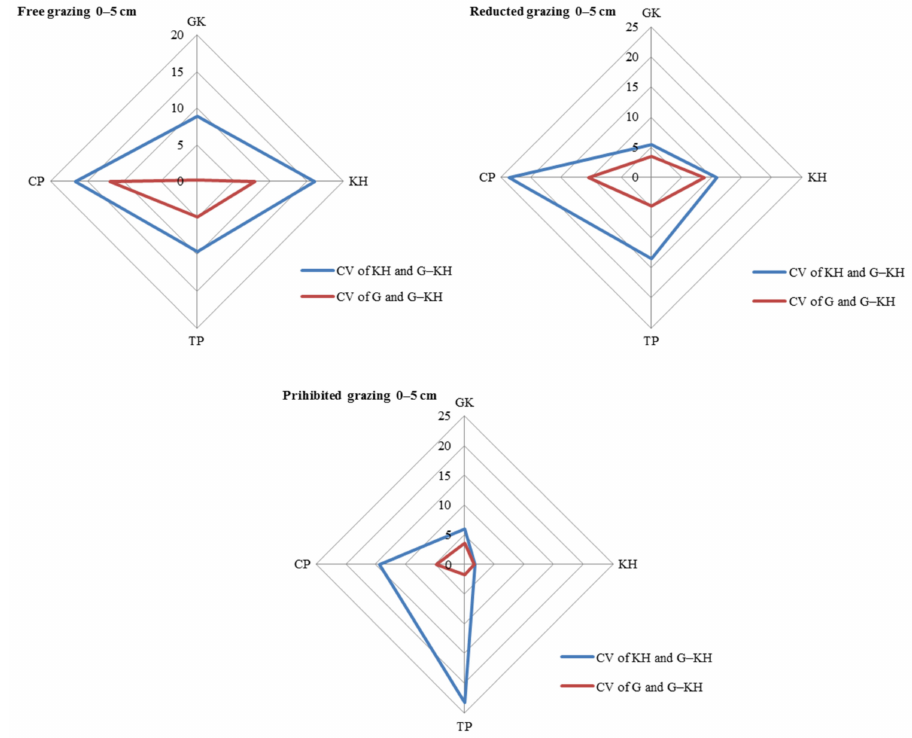
Figure 3. Coefficient of variation (CV) in soil organic matter content in the 0–5 cm layer between micro-patches in the degradation stages. Notes: CV of KH and G-KH: CV between the Kobresia and Kobresia -Gramineae transitional micro-patches; Free grazing 0–5 cm, Reduced grazing 0–5 cm, and Prohibited grazing 0–5 cm: CV in the free-grazing, reduced-grazing, and grazing-prohibited areas, respectively; GK, Gramineae- K. humilis meadow; KH, K. humilis meadow; TP, K. pygmaea meadow with mattic epipedon thickening; CP, K. pygmaea meadow with mattic epipedon